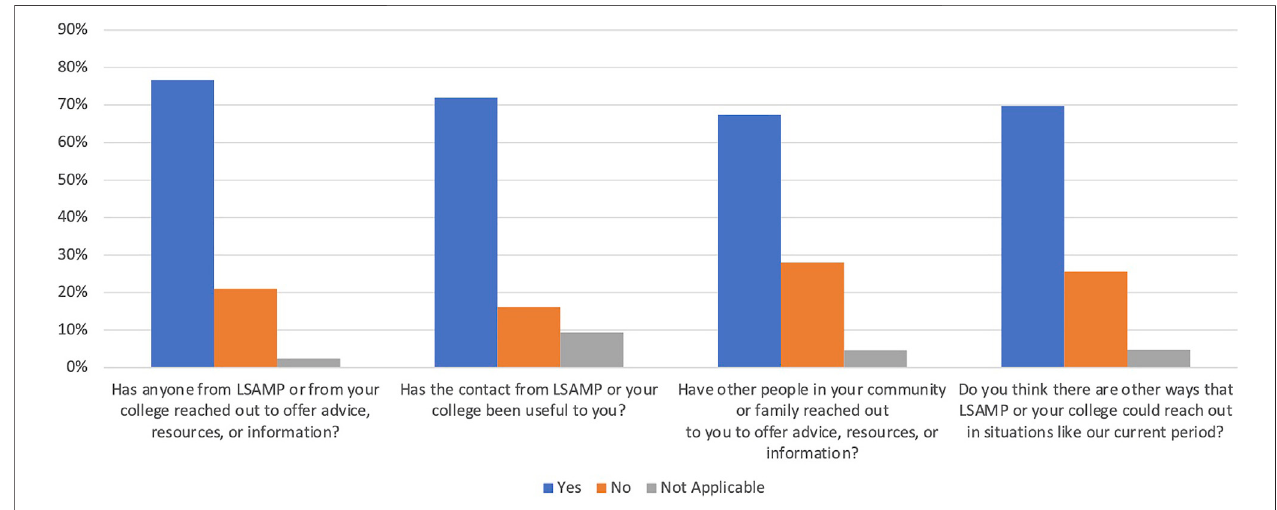
FIGURE 9 | Satisfaction with supports